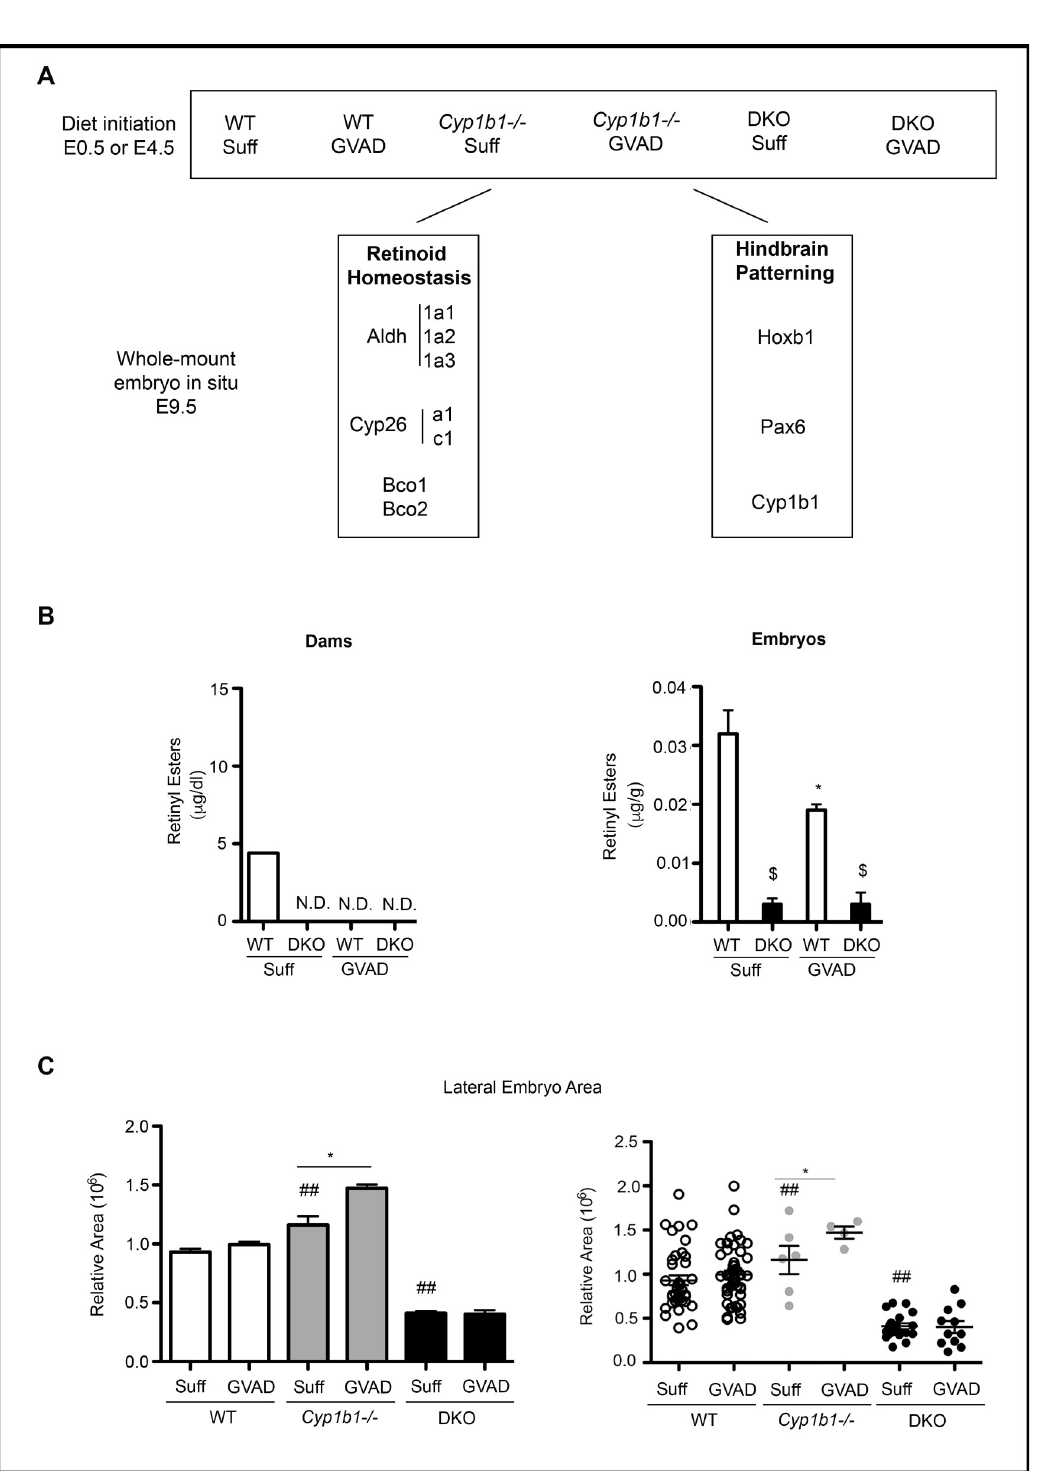
Fig 3. Retinoid homeostasis in WT, Cyp1b1-/- and DKO mice. Experimental design for embryos at E9.5 and pups at birth and weaning. C57Bl/6J (WT), Cyp1b1-/-, and DKO pregnant dams were administered vitamin A-sufficient (Suff) or -deficient (GVAD) diets at E4.5 (or E0.5 for DKO dams). Whole mount in situ hybridization (ISH) at E9.5 was used to observe the intensity and location of genes involved in retinoid homeostasis and developmental patterning (A). Depletion of serum retinol and retinyl esters at E14.5 in DKO dams and fetuses on Suff and GVAD maternal diets. Data previously published as a Table [33] (B). � p- value � 0.05 compared to sufficient within the same genotype. $p-value � 0.05 compared to WT on the same diet. N.D., Not detectable ( < 0.01 μ g/dl). E9.5 embryo sizes obtained from dorsal projections for the six treatment groups (C). https://doi.org/10.1371/journal.pone.0228436.g003 PLOS ONE | https://doi.org/10.1371/journal.pone.0228436 February 6,